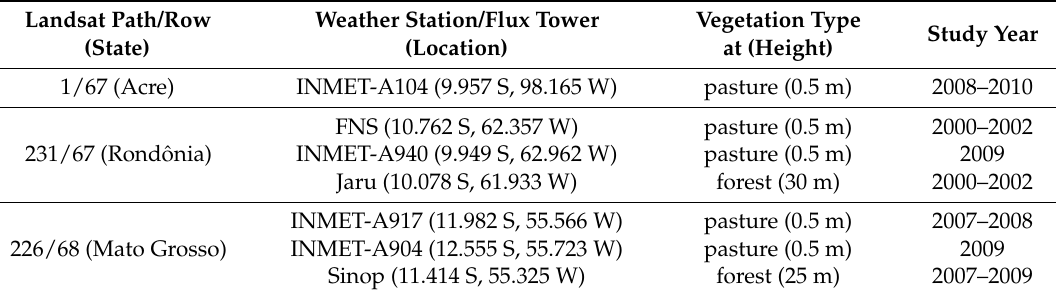
Table 1. Summary of study site and weather station/flux tower information.